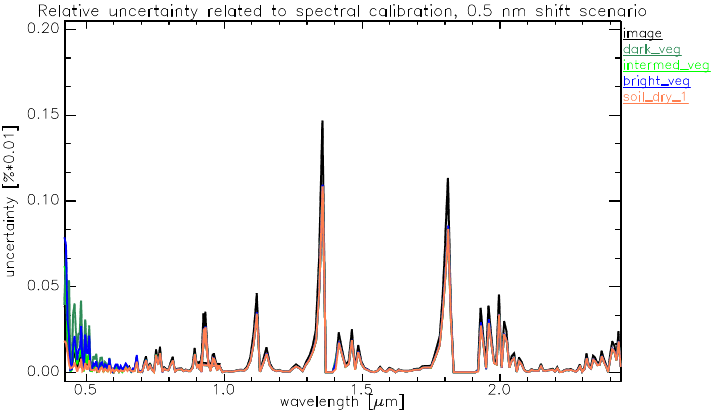
Figure 14. Plot of the absolute standard deviation (stdev) for all ROI classes, representing the combined standard uncertainty.